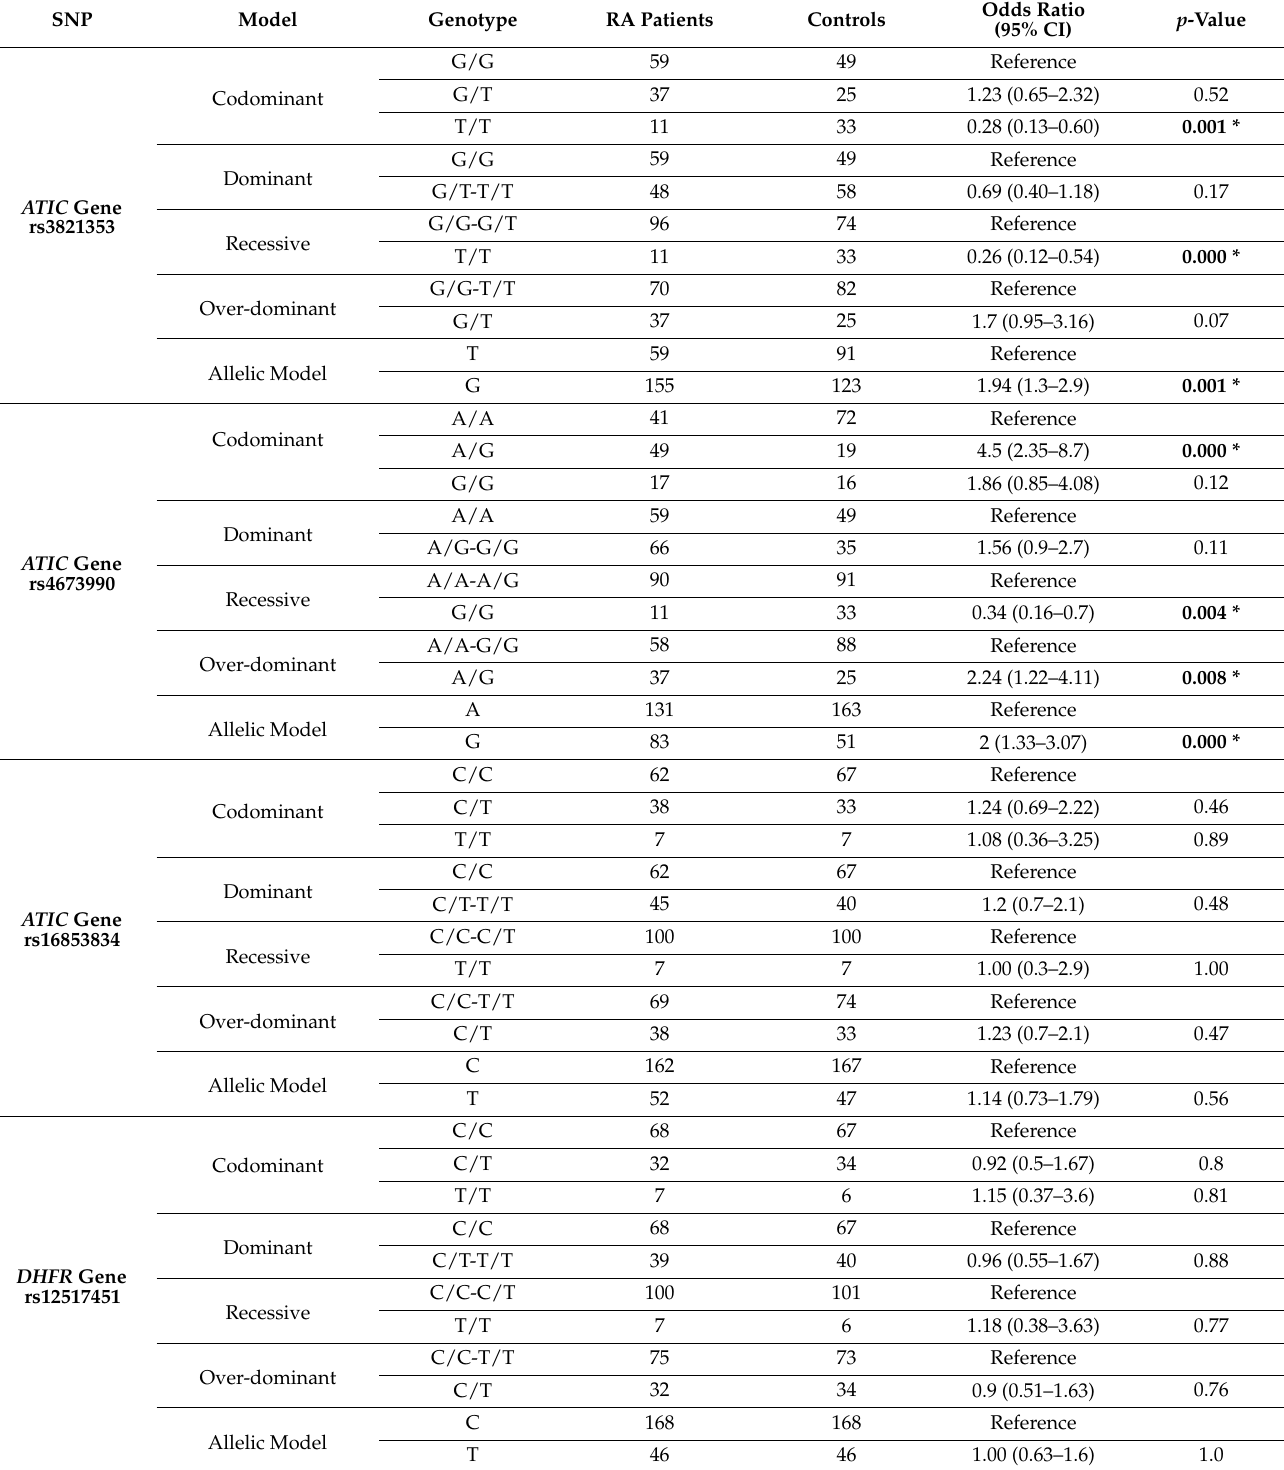
Table 4. Genetic association models for methotrexate pathway genes with rheumatoid arthritis disease